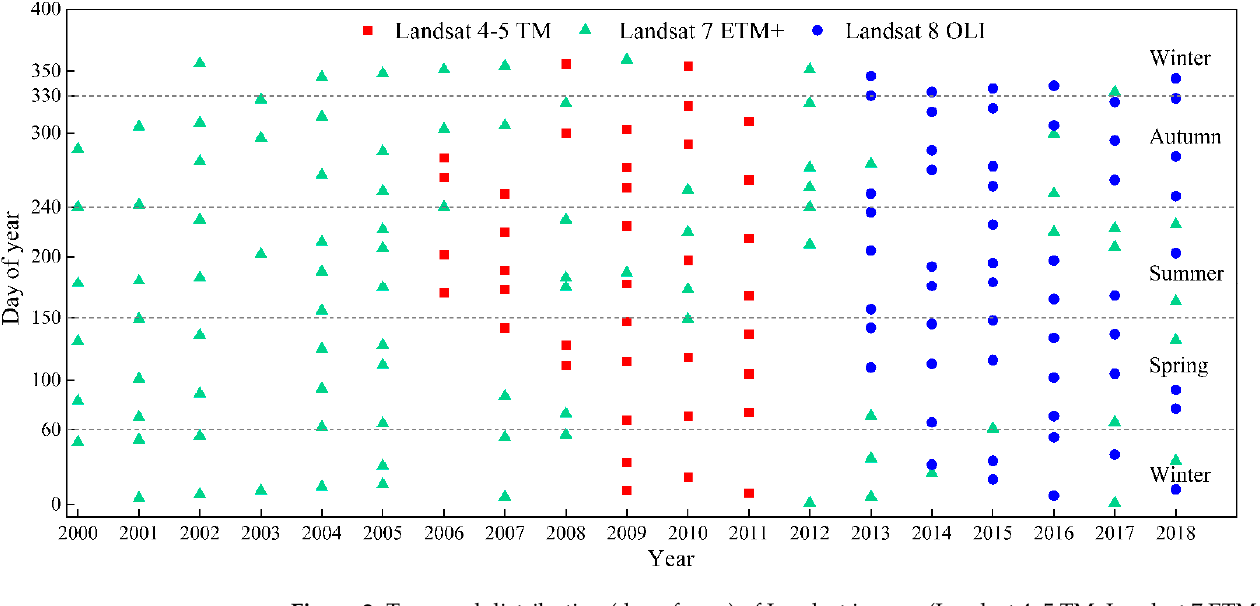
Figure 2. Temporal distribution (day of year) of Landsat images (Landsat 4–5 TM, Landsat 7 ETM+, and Landsat 8 OLI) from 2000 to 2018 used in this study. Blank regions represent missing remote sensing images.